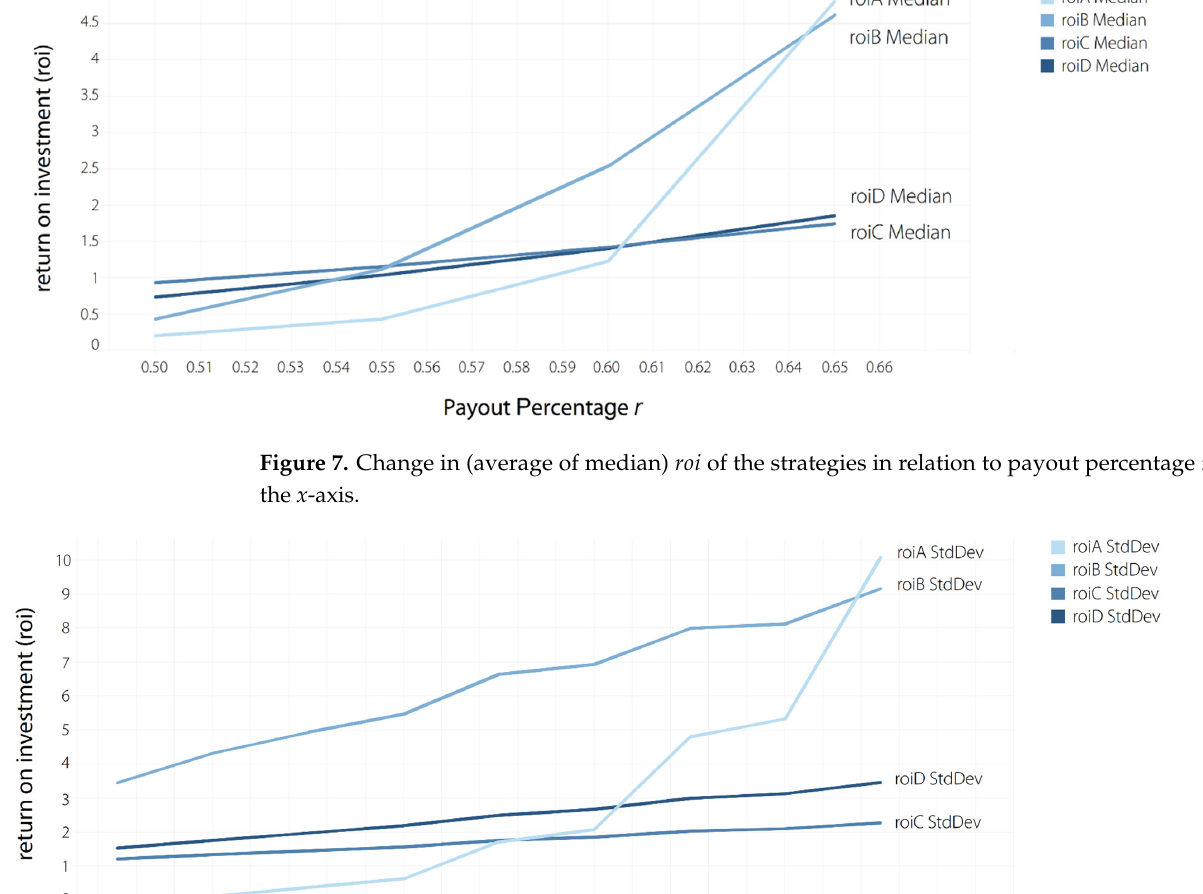
Figure 6. Change in (median) roi StdDev of the strategies in relation to prediction accuracy p on the x -axis.